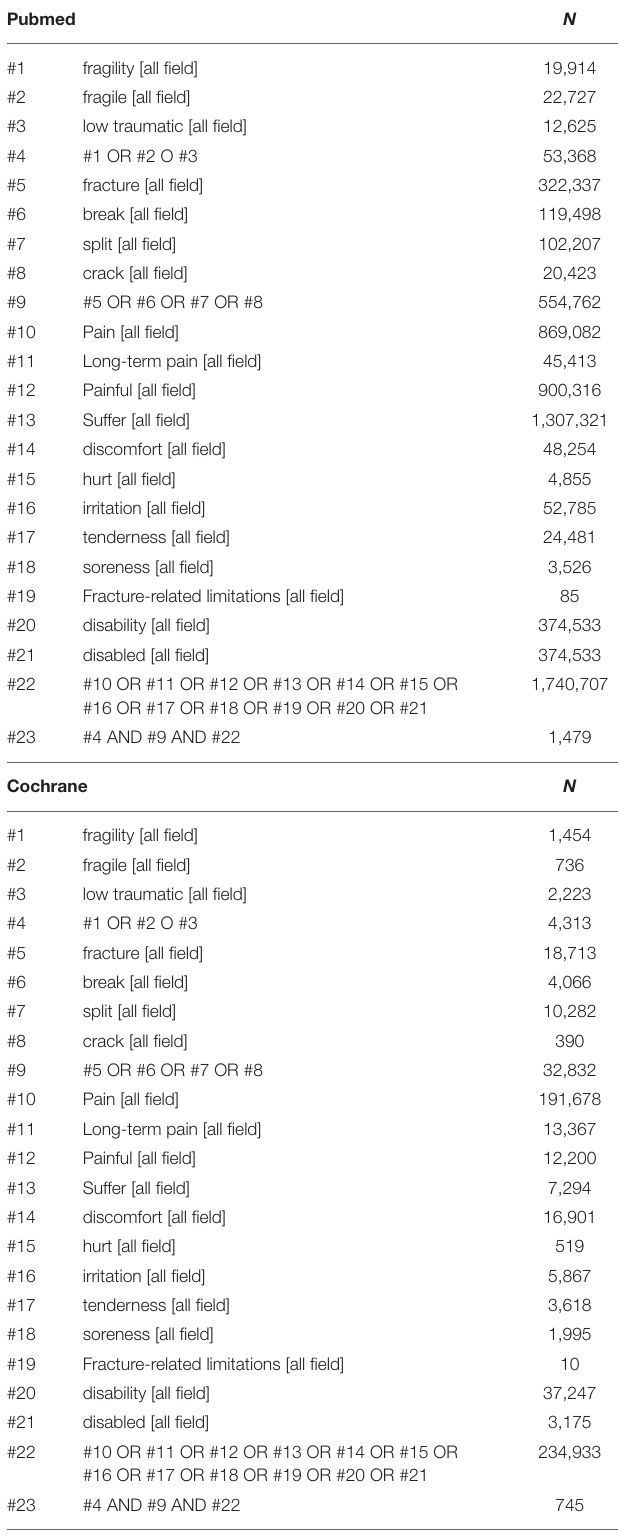
TABLE 1 | Search strategy in PubMed up till Febuary 4th,